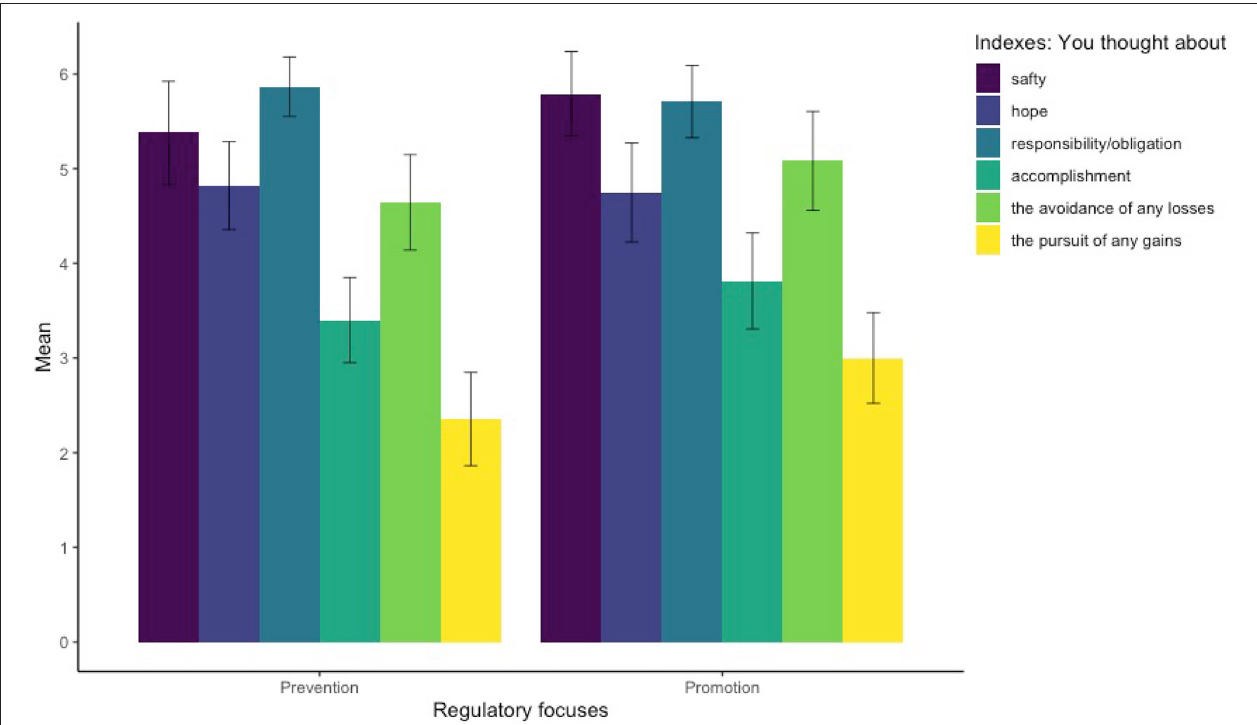
FIGURE 1 | Prevention and promotion indexes. On a 7-point Likert scale (from 1 = strongly disagree to 7 = Strongly agree ). Error bars are the ± 2 standard error of the mean.